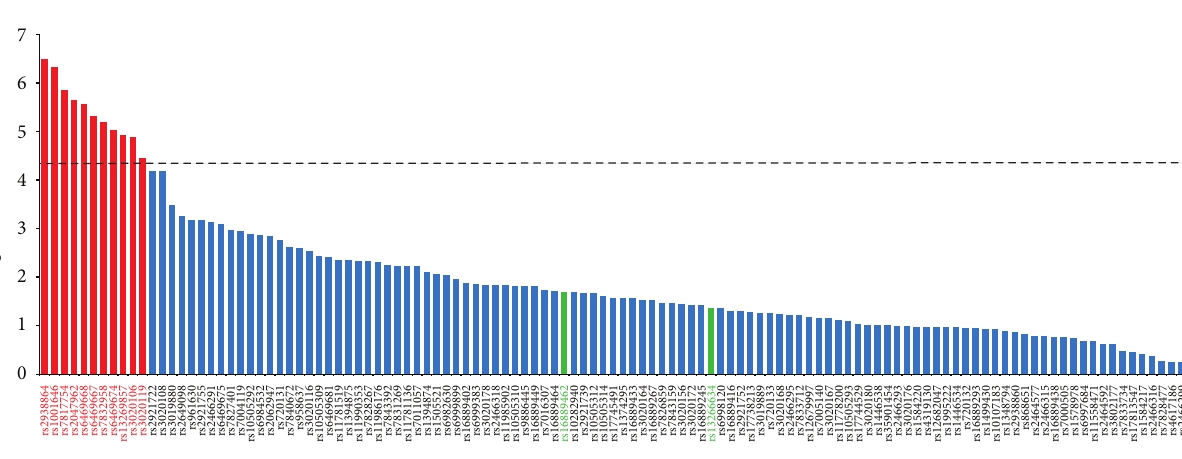
Figure 2: Probability score for the studied SNPs based on strength of association with eight T2D-related traits. Significantly associated SNPs are indicated in red colored bars. Coding variants are labeled in